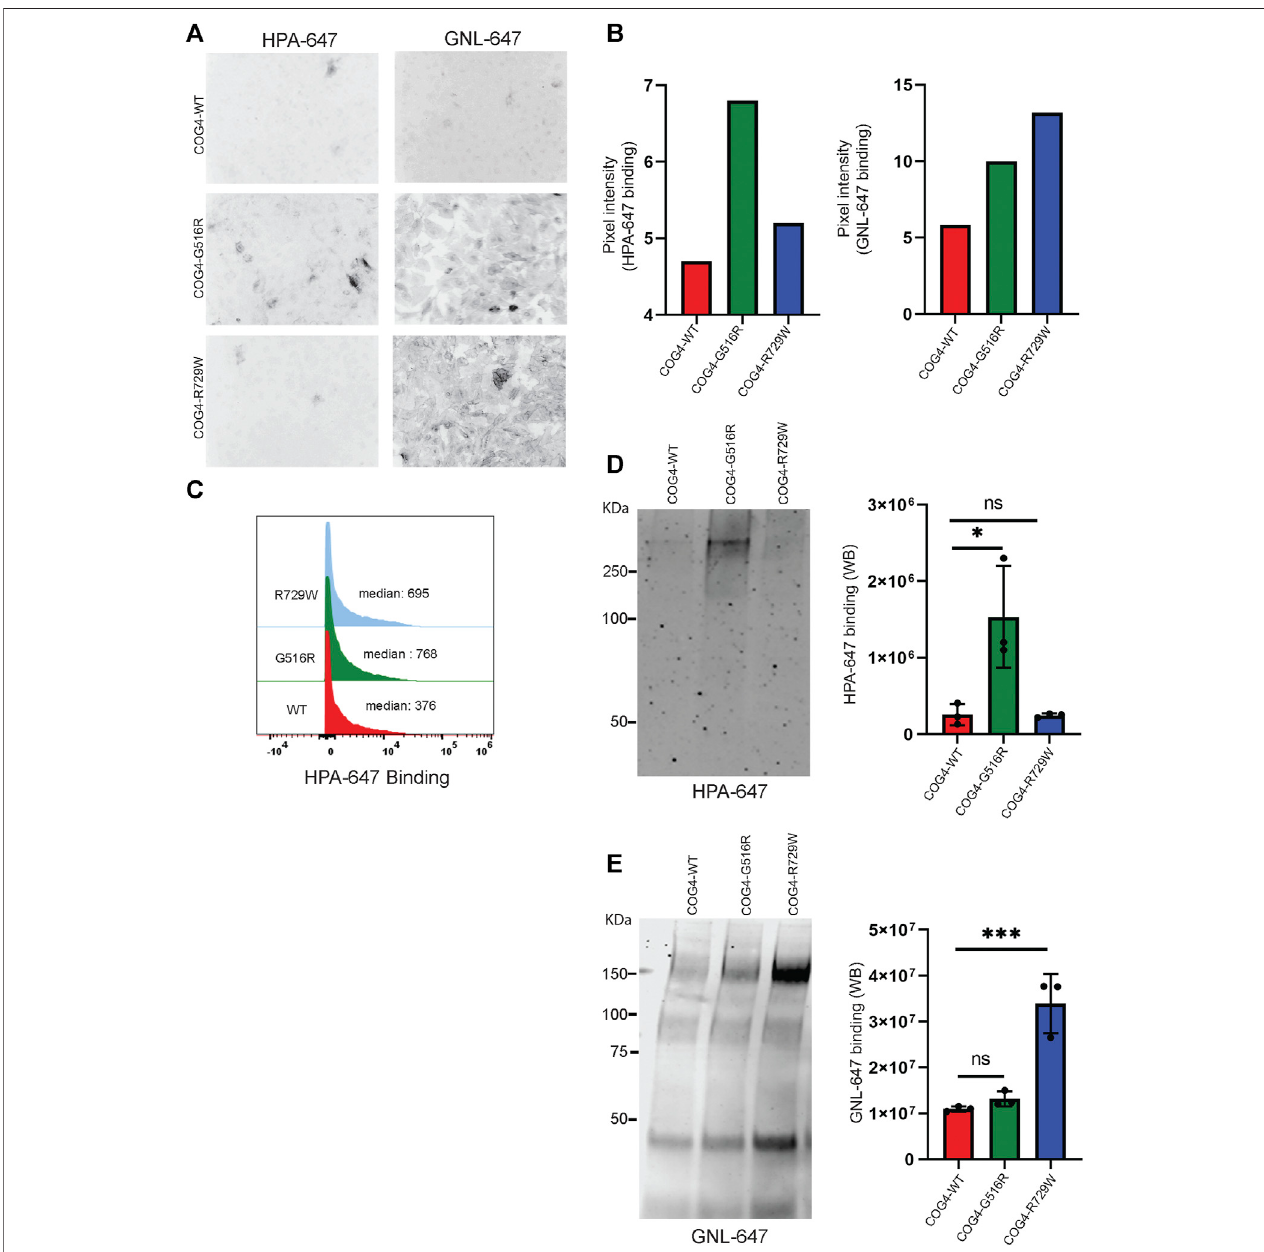
FIGURE 6 | COG4-G516R and COG4-R729W mutations are causing O-glycosylation and N-glycosylation defects, respectively . (A) Non-permeabilized RPE1 rescued COG4-WT-3myc, COG4-G516R-3myc, and COG4-R729W-3myc cells were stained with the fl uorescently conjugated lectins HPA-647 (speci fi c for terminal GalNAc residues) and GNL-647 (speci fi c for terminal α -D-mannosyl residues). The images were taken by Zeiss Axiovert 200M fl uorescent microscope using a × 20 objective. (B) The pixel intensity of the full image for each cell line has been measured using ImageJ software. The bar graph has been presented with statistical value to provide intensity difference for each lectin (HPA-647, GNL-647) binding among the rescued cell line. (C) Flow cytometry histogram of HPA-647 fl uorescence intensityinCOG4-WT-3myc(red),COG4-G516R-3myc(green),andCOG4-R729W-3myc(blue)populationaftergatingforliveandsinglecells. (D) Westernblotanalysis of the secretion from the rescued cells has been performed by probing with the HPA-647 antibody (left panel). Quanti fi cation of the lectin HPA-647 binding intensity (Right panel). Statistical signi fi cance was calculated by GraphPad Prism 8 using One-way Anova. * p ≤ 0.05, ** p ≤ 0.01 and non-signi fi cant (ns) p > 0.05. Error bar represents mean ± SD. (E) Western blot analysis of the secretion from the rescued cells has been performed by probing with the GNL-647 antibody (left panel). Quanti fi cationofthelectinGNL-647bindingintensity (Rightpanel). Statisticalsigni fi cancewascalculatedbyGraphPadPrism8usingOne-wayANOVA.* p ≤ 0.05,** p ≤ 0.01 and non-signi fi cant (ns) p > 0.05. Error bar represents mean ± SD.